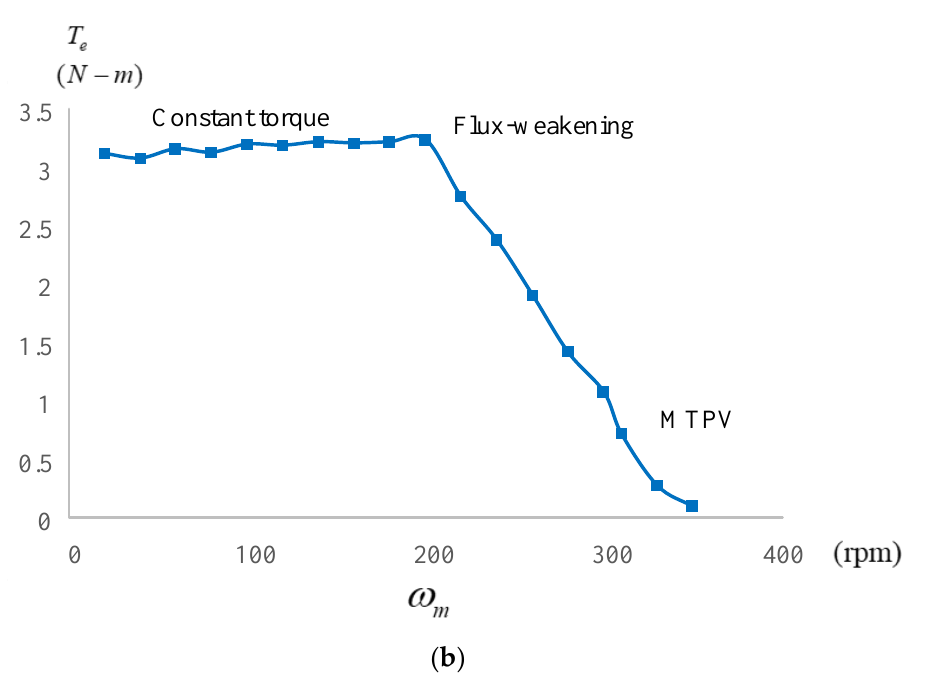
Figure 21. Measured speed responses at 350 r/min with maximum torque/voltage control. ( a ) speeds, ( b ) torque-speed curve.